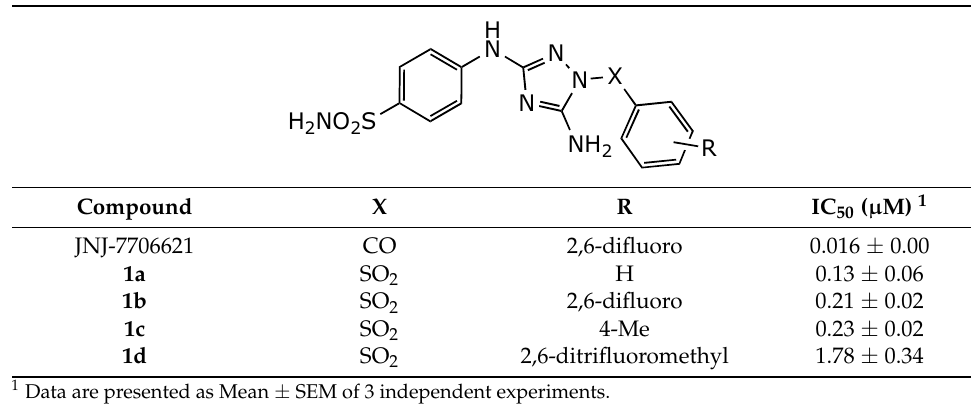
Table 1. Inhibitory activity of the developed compounds against Aurora-A kinase.